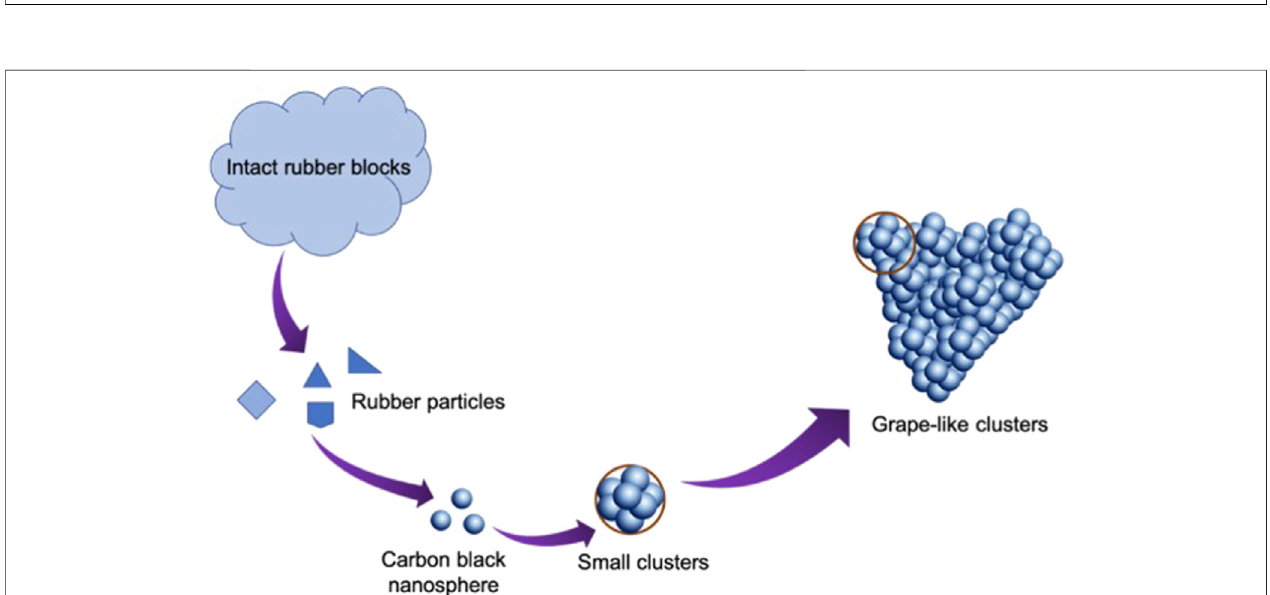
FIGURE 5 | The mechanism of the formation of carbon black clusters during the hydrothermal treatment of tire rubber.